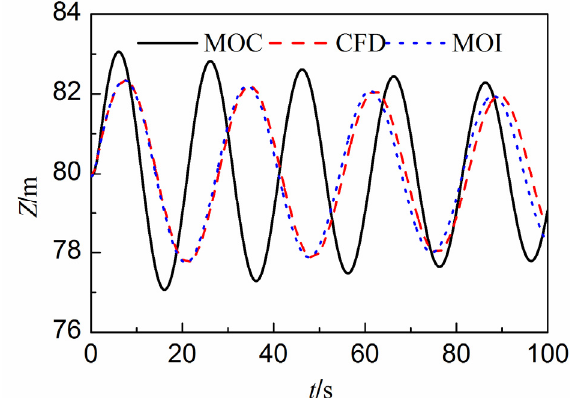
Figure 15. Oscillation of water level for Case 2.